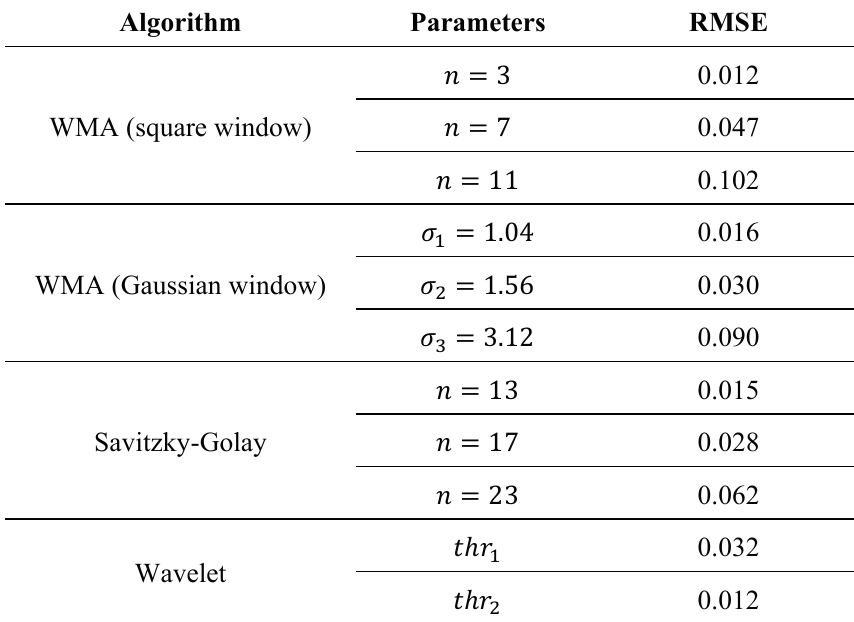
Table 3. Root mean square error (RMSE) between the covariance of the original data and the covariance of the smoothed data at 684 nm.